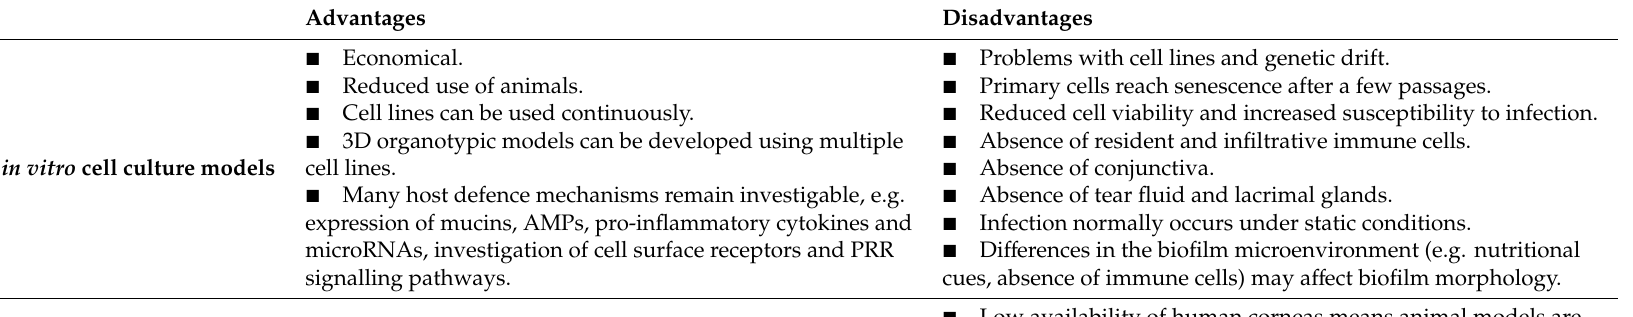
Table 1. Evaluation of in vitro , ex vivo and in vivo corneal models for the study of bacterial keratitis